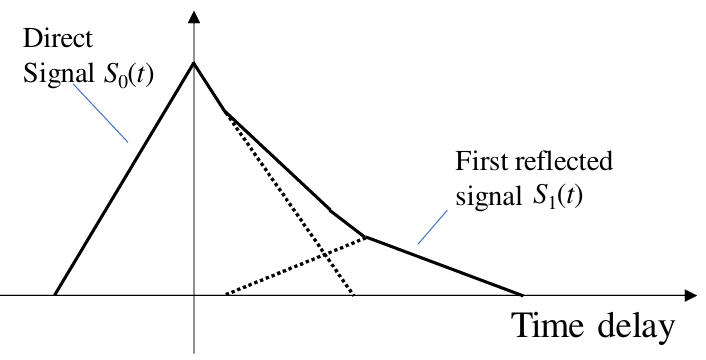
Figure 3. Correlation function of an LOS multipath signal.